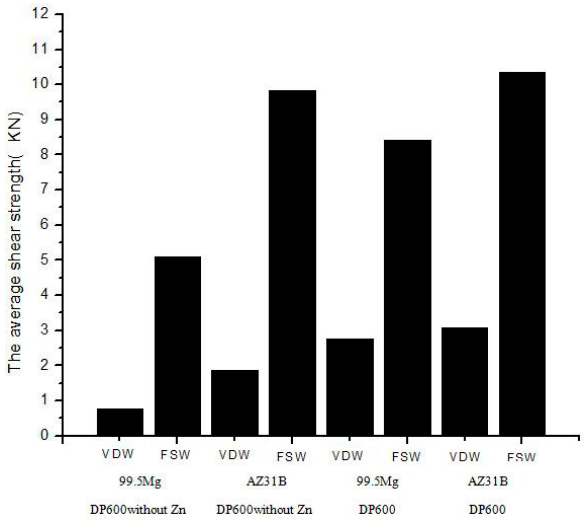
Figure 10. The histogram of tensile properties of samples.